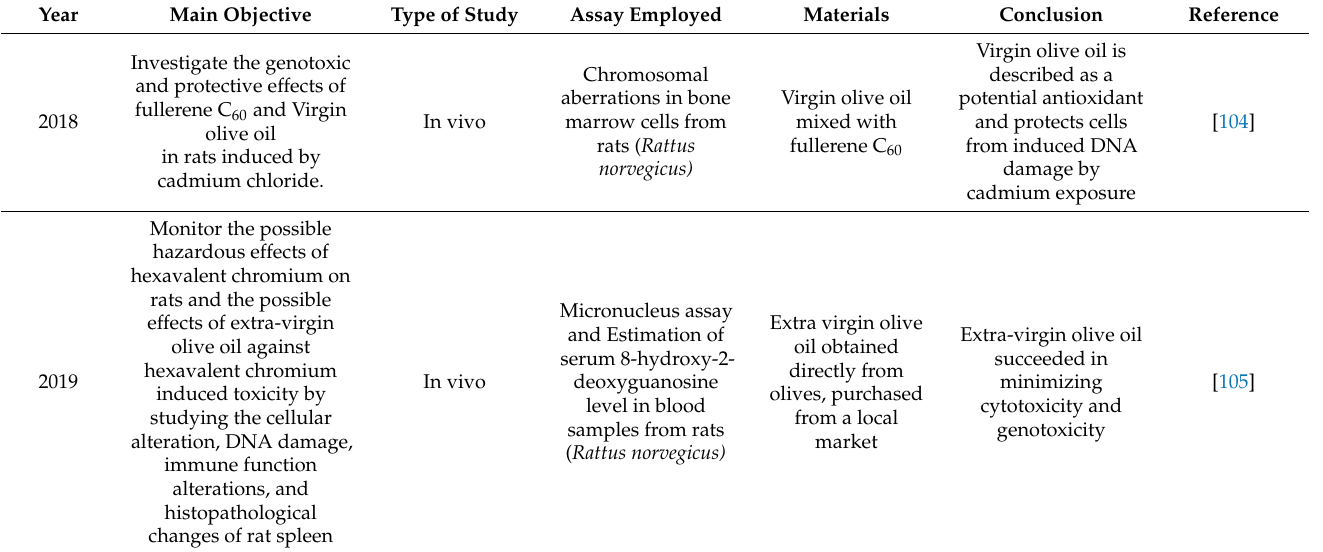
Table 3. Relevant studies of